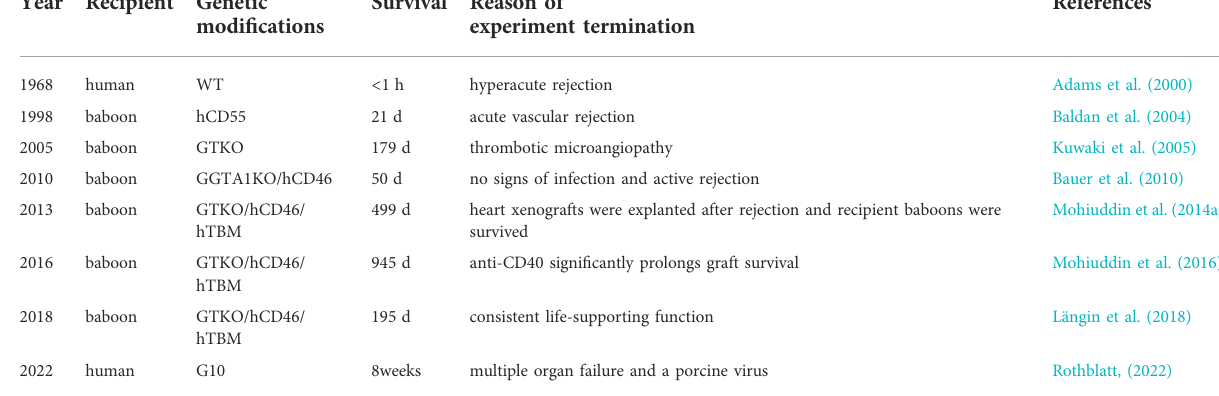
TABLE 1 Progress in transgenic porcine heart